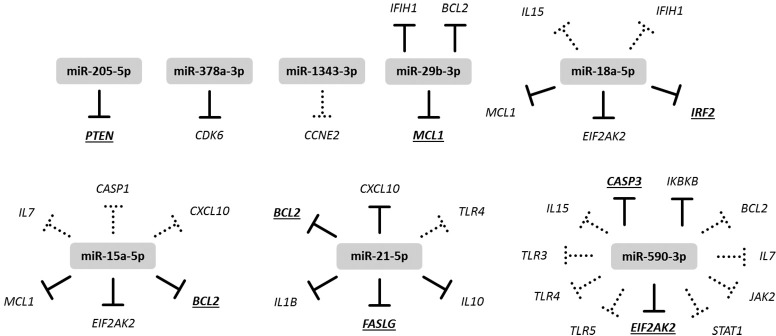
Potential miRNA-mRNA interactions.Expression of eight of the assayed miRNAs showed significant negative correlation with expression of protein coding genes that were identified (using RAIN v1.0 [50], TarBase v. 7.0 [52], and/or microT-CDS [53]) to be experimentally validated targets of the miRNA (solid lines), computationally predicted targets of the miRNA (dotted lines), or both (solid lines, underlined gene names).